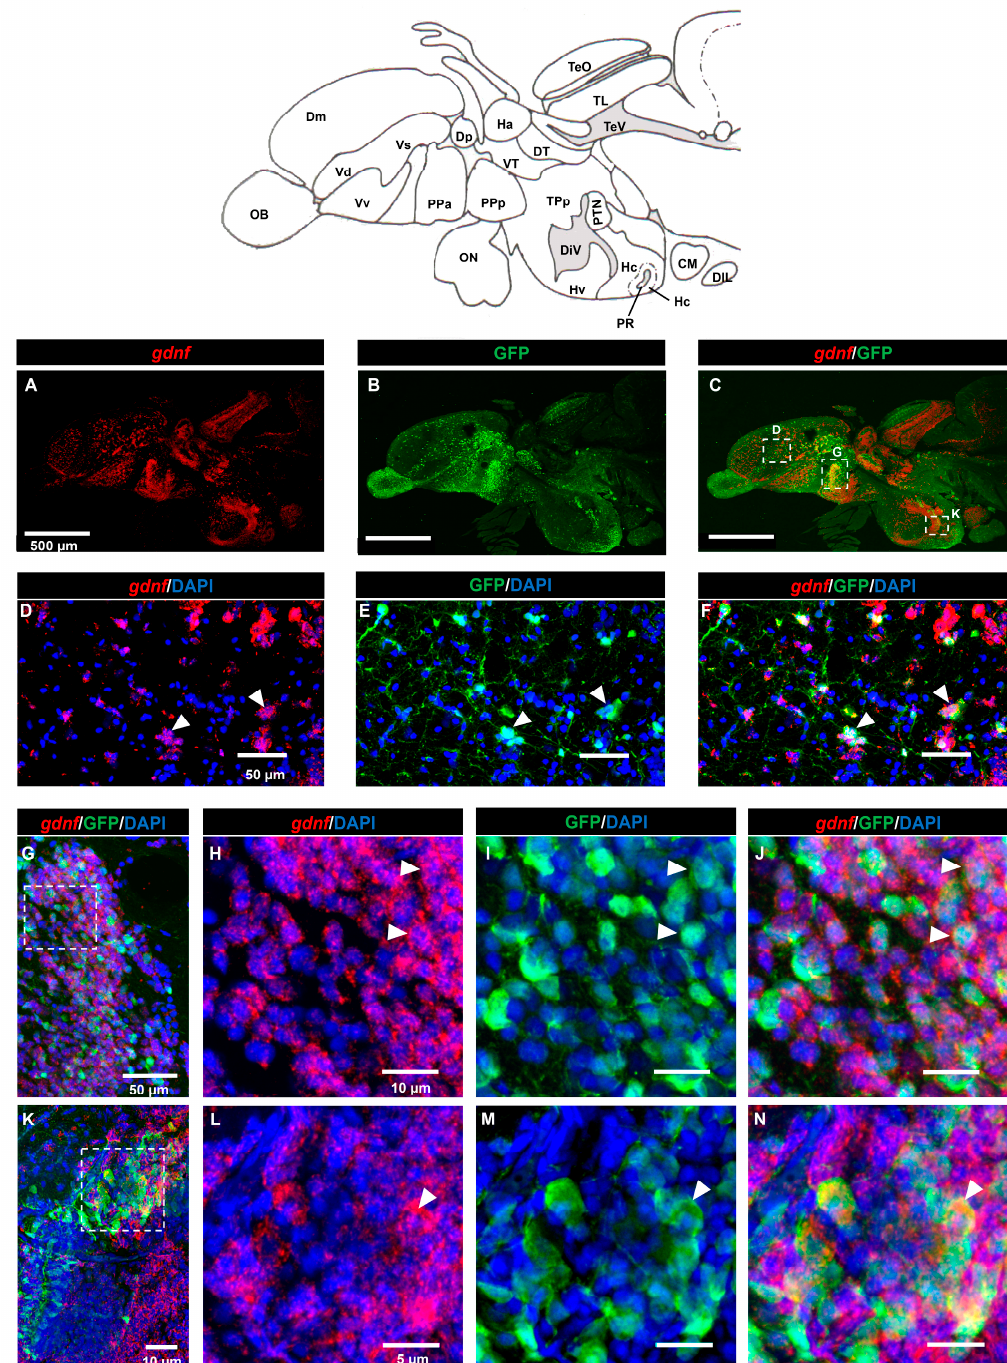
Figure 4. Expression of gdnf in GABAergic precursor cells of Tg ( dlx6a-1.4kbdlx5a / 6a: green fluorescence protein (GFP) fish. ( A – C ) An overview of gdnf transcripts (red) and GFP on a sagittal view of the adult zebrafish brain. The images depict co-localization of gdnf with subpopulation of GFP-positive cells in ( D – F ) pallium ( G – J ) parvocellular preoptic nucleus, anterior part (PPa), and ( K – N ) caudal zone of periventricular hypothalamus (Hc) as indicated with white arrowhead. The white dashes outline the enlarged regions that were constructed from selected z-stacks. Abbreviations: CM: Corpus mamillare; Dm: medial zone of dorsal telencephalic area; DIL: Di ff use nucleus of the inferior lobe; Dp: Posterior zone of dorsal telencephalic area; DiV: Diencephalic ventricle; Ha: Habenula; DT: Dorsal